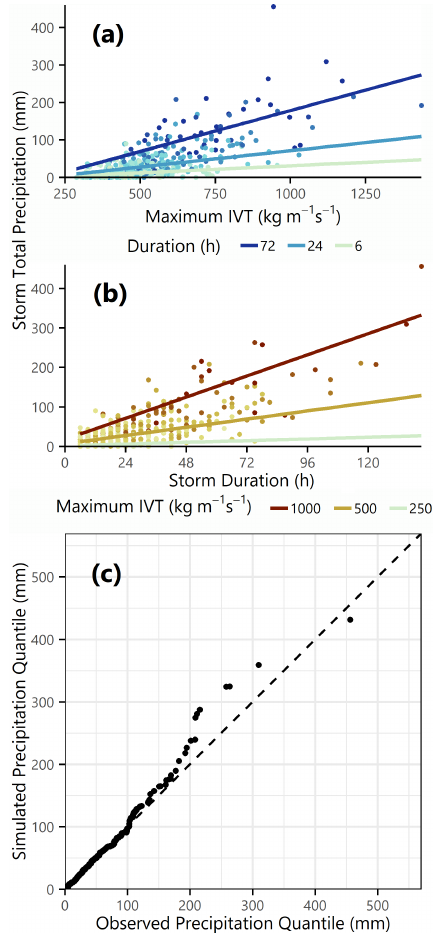
Figure 4. Precipitation component model implementation. Scatter- plots of (a) maximum IVT vs. precipitation and (b) duration vs. pre- cipitation, with the fitted WLS regression line shown for values specified in the respective legends. (c) Q–Q plot of observed vs. simulated precipitation including uncertainty for all AR events in the historic